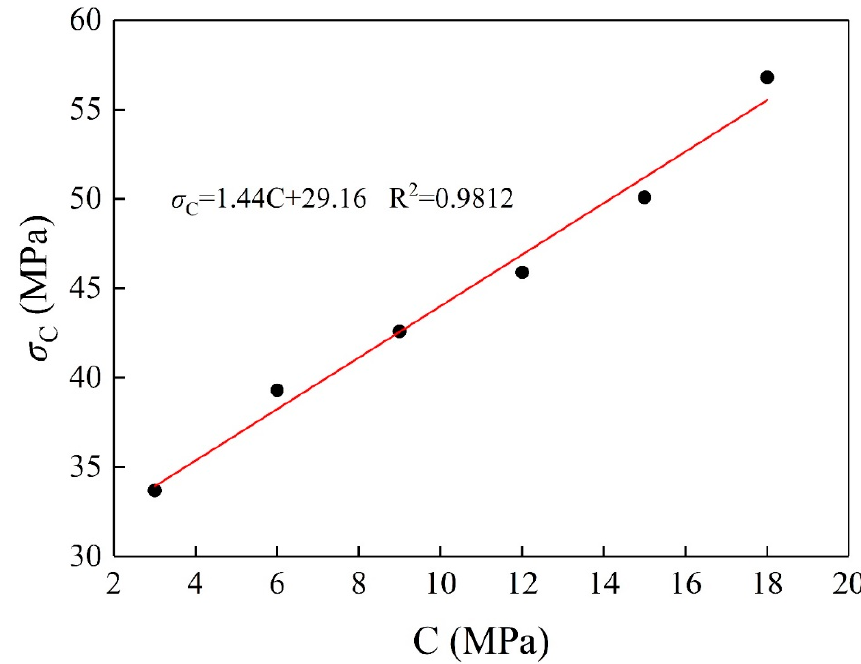
Figure 7. Creep failure strength of AS samples under di ff erent confining pressures.